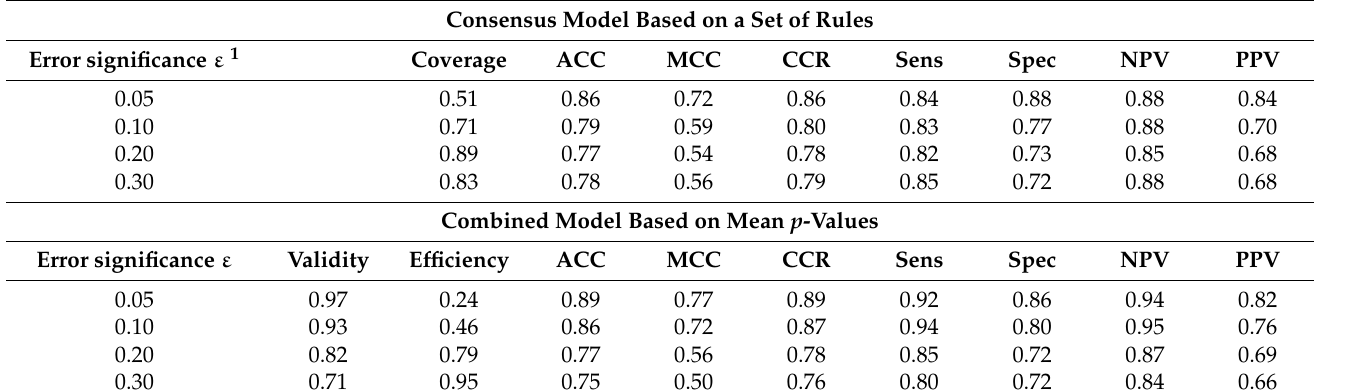
Table 5. Performance of the consensus and the combined models on the test